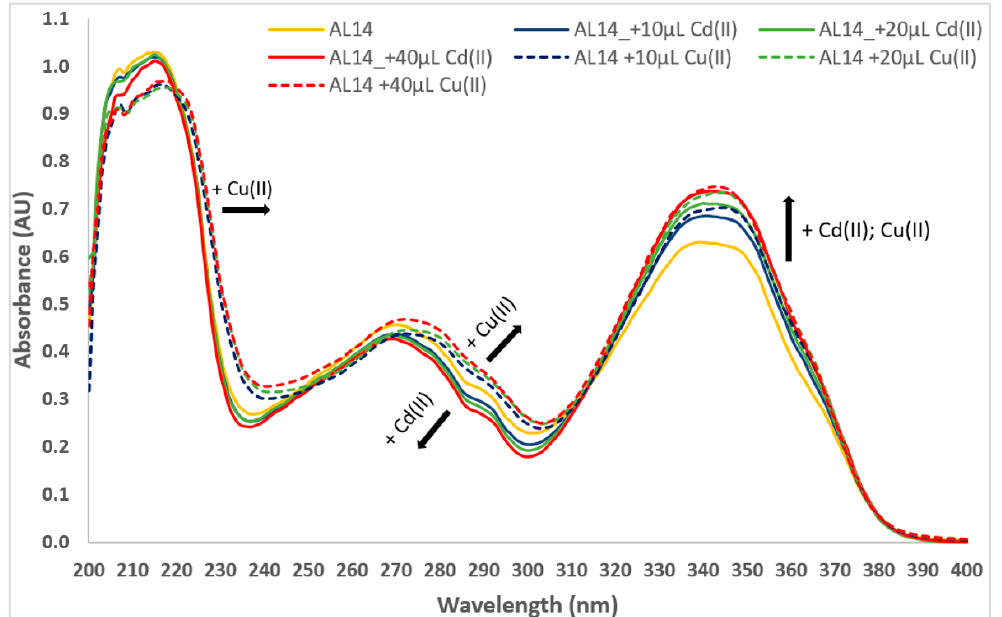
Figure 5. UV-Vis spectra of 3-((5-(trifluoromethyl)-1,3,4-thiadiazol-2-yl)amino)benzo[d]isothiazole 1,1-dioxide (AL14), in ethanol, with different volumes of Cd(II) or Cu(II) addition.